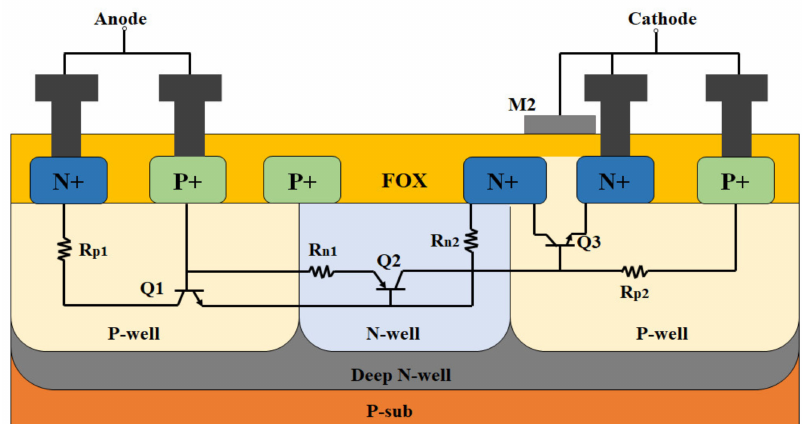
Figure 5. LVTSCR-Based ESD Protection Structure.